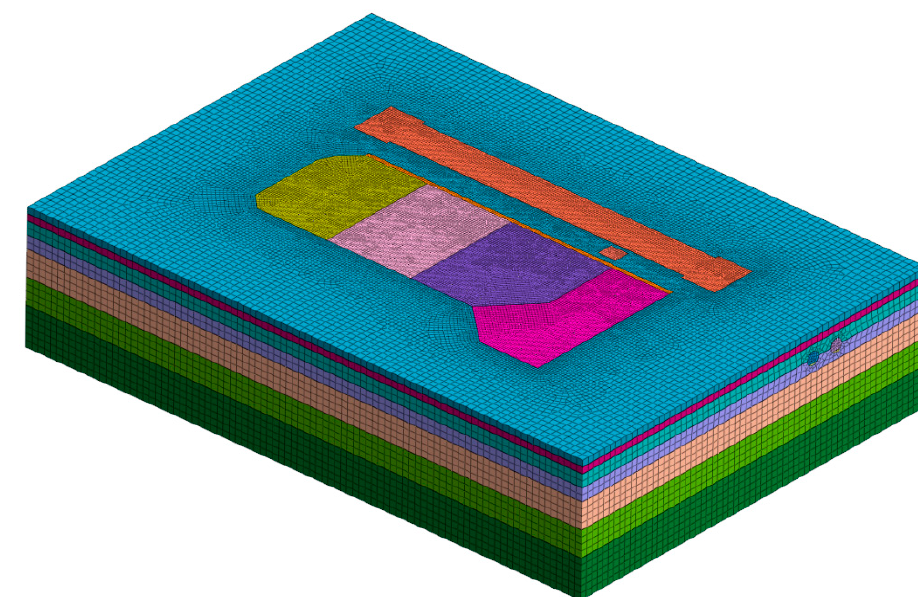
Figure 18. Overall model diagram.